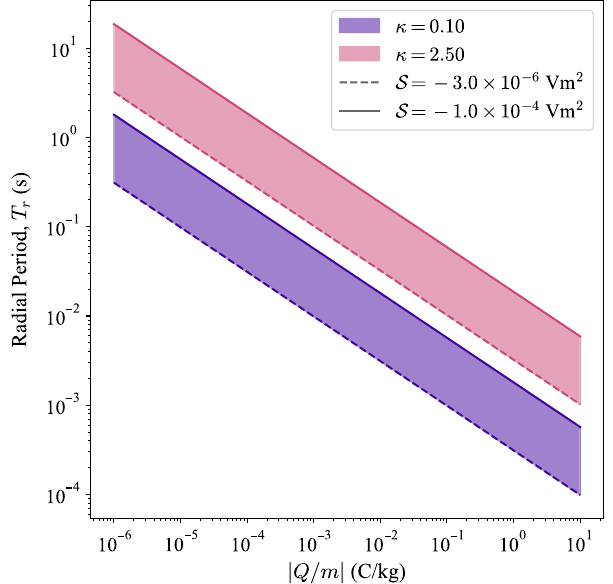
FIG. 9. Period of the radial oscillation for dust grains orbiting the LHC beam as a function of the charge-to-mass ratio. The period is smaller for quasicircular orbits ( κ ¼ 0 . 1 ) than for elongated orbits ( κ ¼ 2 . 5 ) but also scales with S